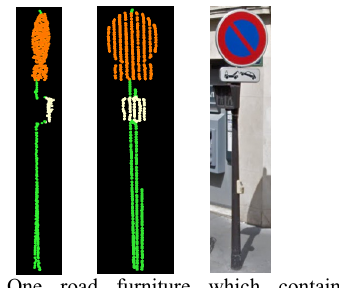
Figure 7. One road furniture which contains an unrecognised traffic light (white points) in Dataset B From the result, we conclude that poles can be extracted well. Street lights can be recognised reliably if the point cloud is dense and of good quality. Some street signs are labelled as traffic lights because these street signs are still connected with each other and not separated. The reason is the data is too noisy. As illustrated in the second image of Fig. 8, component 1 (yellow area) and component 2 (red zone) should be separated. Due to the noisy data, component 1 and component 2 are not separated by decomposition algorithm (the first image of Fig. 8), which results in the misrecognition.